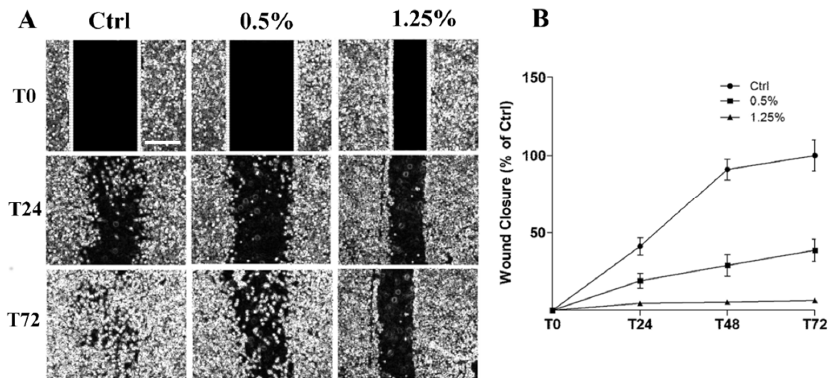
Figure 3. Cell migration evaluated by Wound Healing assay in 1321N1 cells untreated and treated with different concentrations of Rapha Myr ® extract (0.5 and 1.25% v/v ). ( A ) Phase contrast microscope